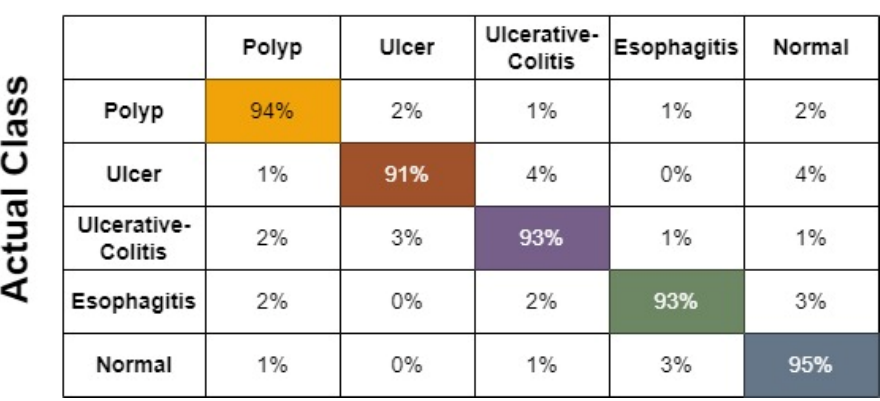
Figure 12. Confusion matrix using softmax classifier for mixed dataset (original images + augmented contrast enhanced images).